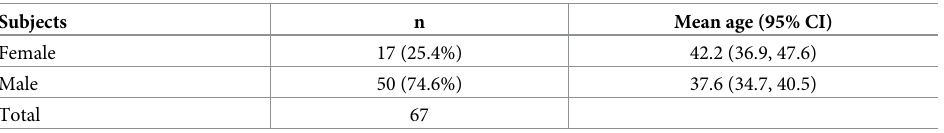
Table 5. Study 2a cohort